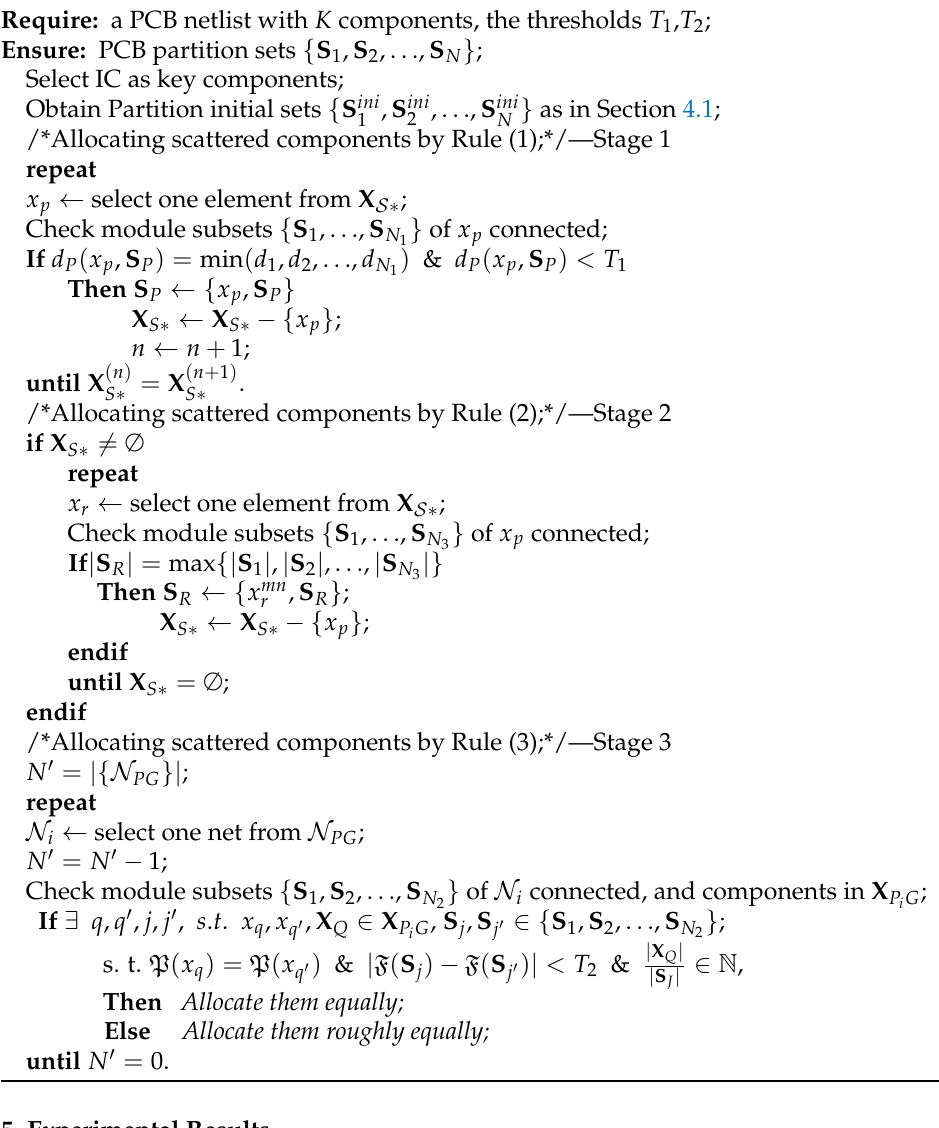
Algorithm 1 The algorithm of circuit partitioning for PCB netlist based on net